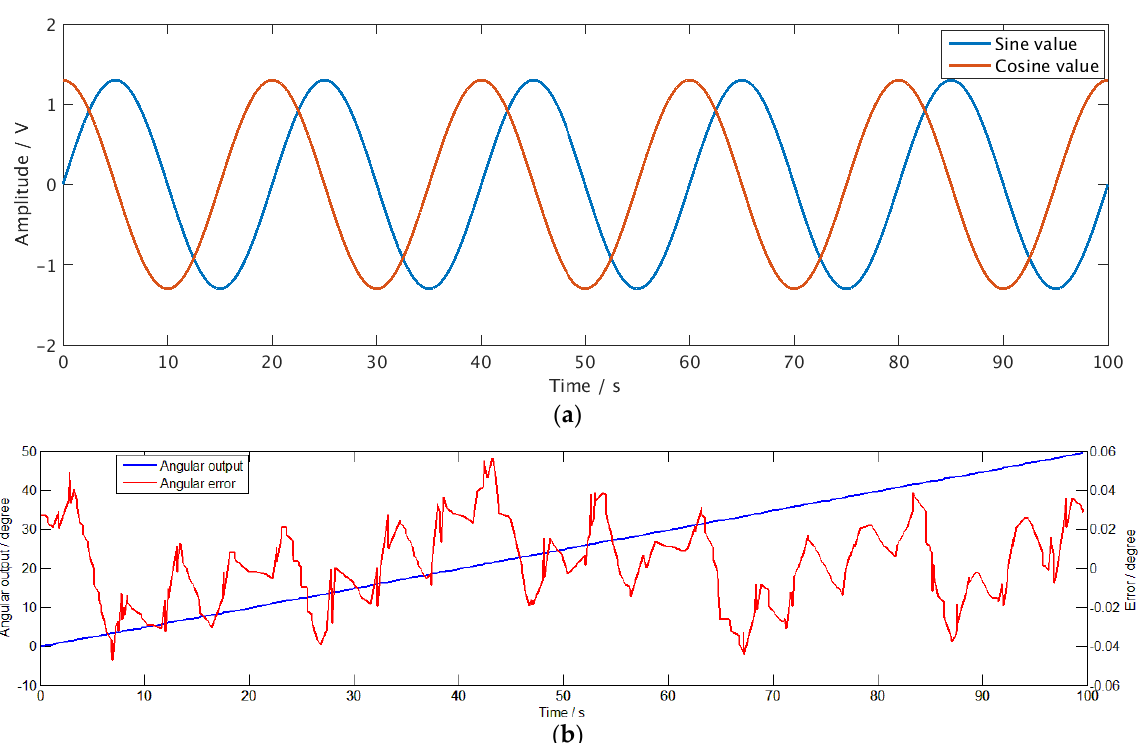
Figure 10. The testing site and testing boards. ( a ) Equipments for function testing; ( b ) step test of an angular displacement sensor.